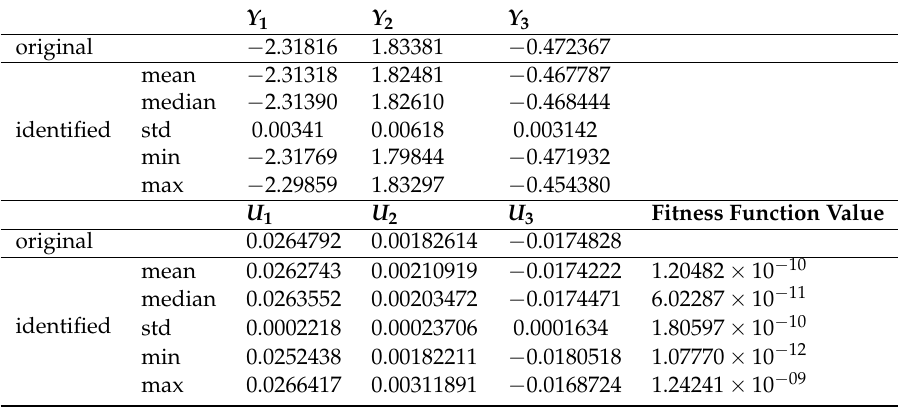
Figure 13. The step response of original, identified and approximated system [49]. Table 1. Exploratory statistics corresponding to hundredfold repeating of simulation